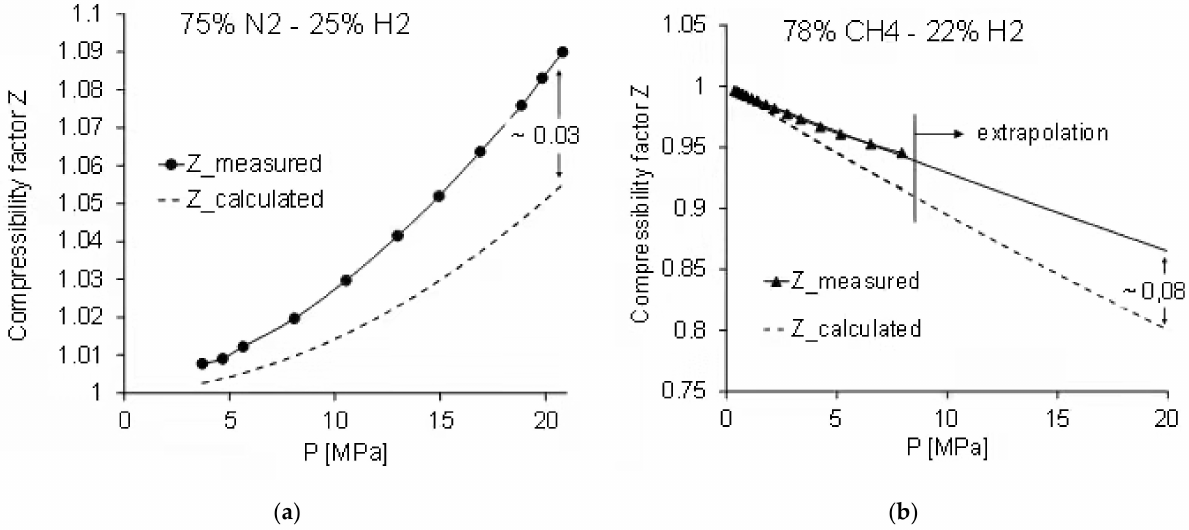
Figure 3. Measured and calculated compressibility factors for ( a ) a 75%N 2 –25% H 2 gas mixture [17] and ( b ) a 78% CH 4 –22% H 2 gas mixture data from [21] as a function of total pressure P .